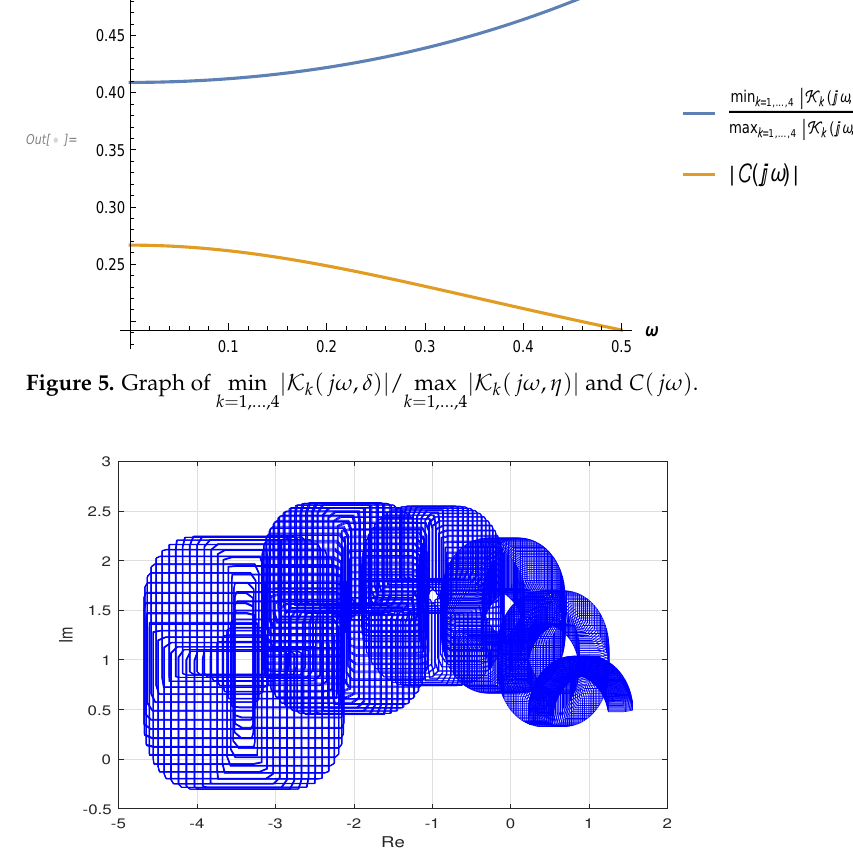
Figure 6. Value set of the stabilized interval plant defined in Example 1 when ω = 1 and τ